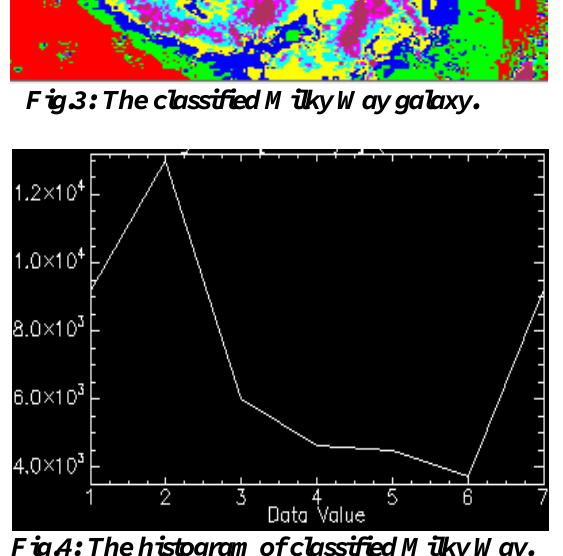
Fig.4: The histogram of classified Milky Way. Table 1: The statistical properties of each band Basic